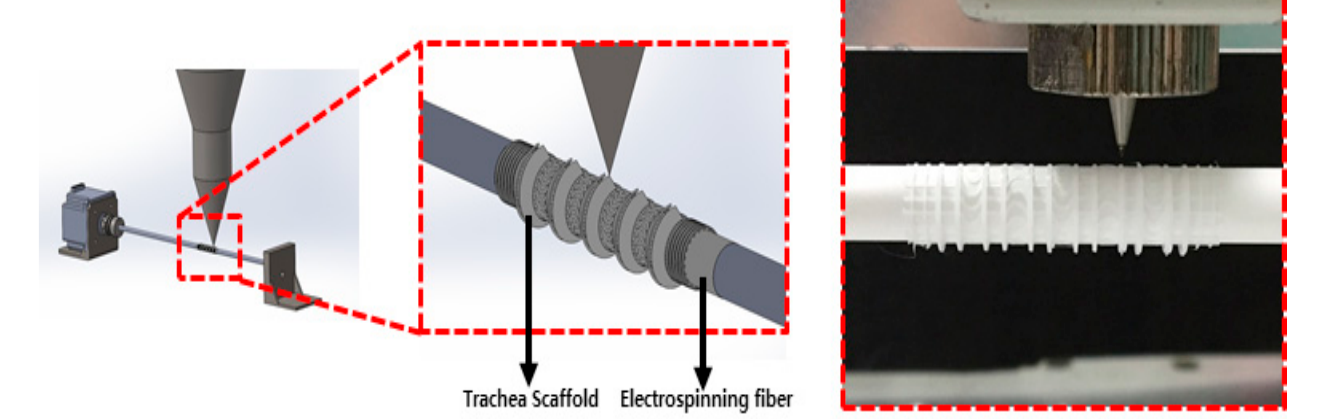
Figure 4. Schematic of the trachea scaffold fabrication.